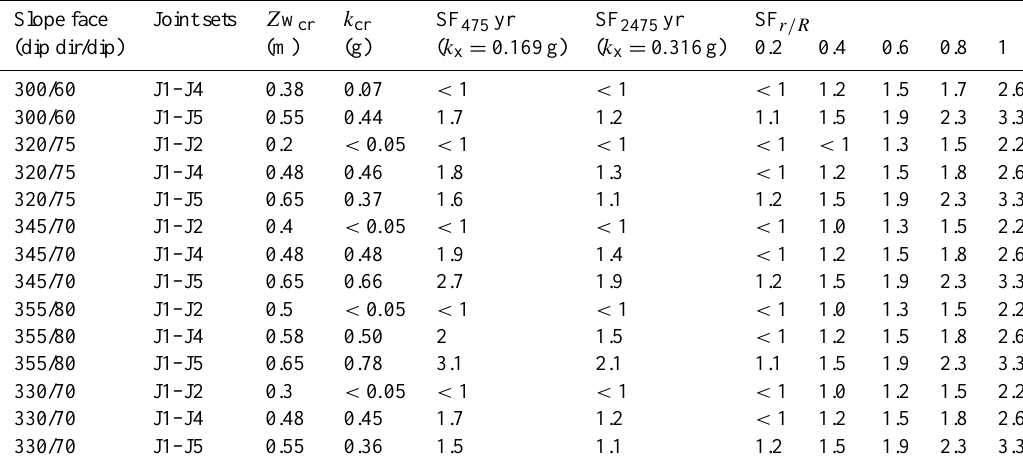
Table 6. Stability analysis of rock wedges at Mt. Pucci: Z w cr – critical height of the static water filling the joints; k cr – pseudo-static critical acceleration; SF 475 – safety factor computed for a pseudo-static seismic action with a return time of 475yr; SF2 475 – safety factor computed for a pseudo-static seismic action with a return time of 2475yr; SF r/R – safety factor for weathered joint conditions ( r/R is the weathering joint ratio; De Vallejo,